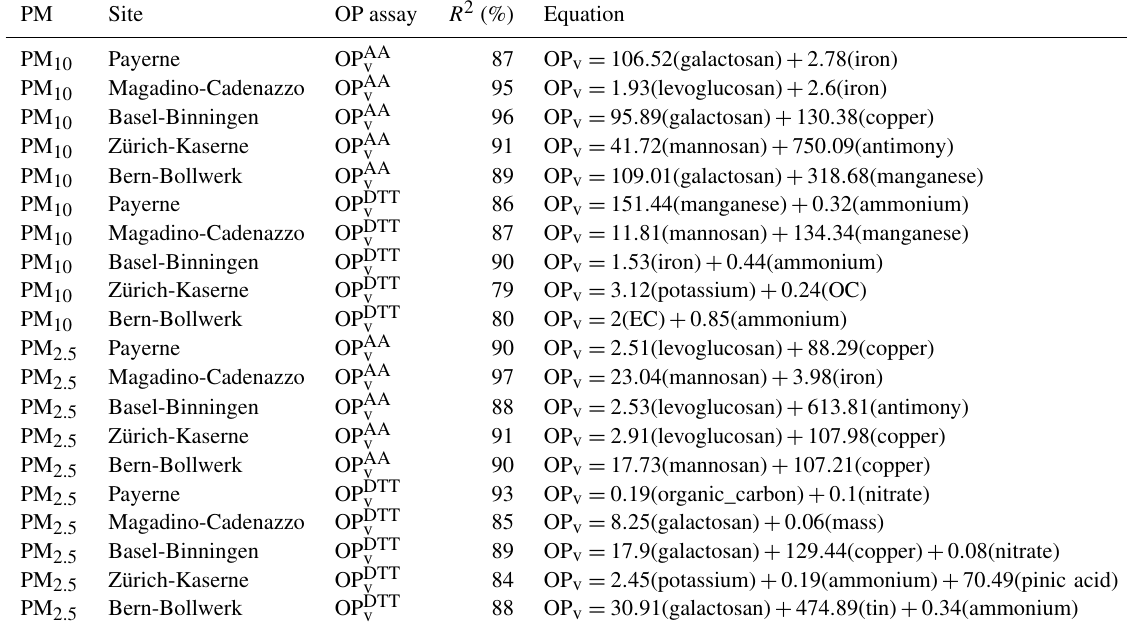
Table 3. The best-performing robust multiple linear regression model equations for each site, two PM fractions, and two OP v assays. The units used for the independent variables are µgm − 3